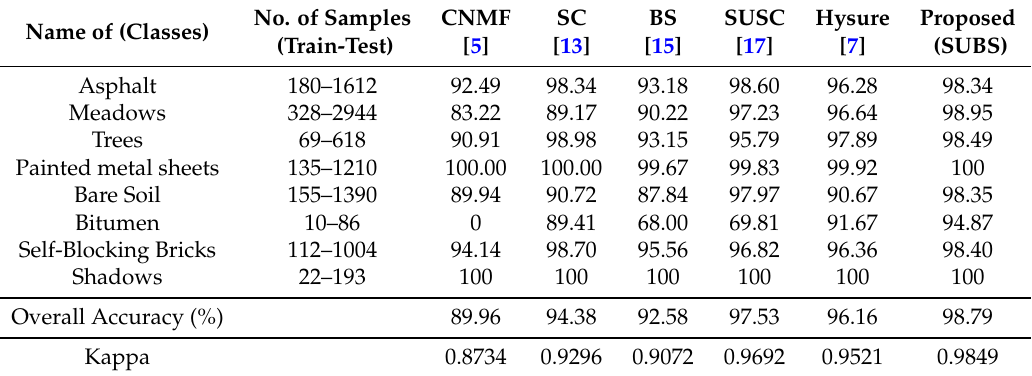
Table 3. The classification accuracy for the Pavia dataset (256 × 256 × 93).